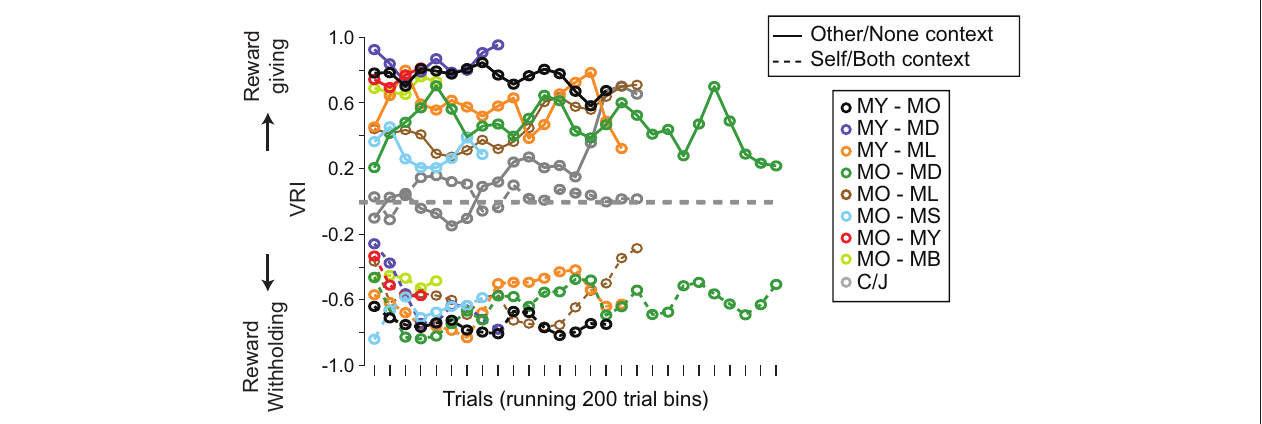
Figure 4 | Temporal progression (moving 200-trial bins with a step size of 100 trials) of context-dependent Vr indices for individual M1–M2 pairs (8 pairs, 64 sessions) and M1–C/J pairs (2 pairs, 13 sessions; see box for pair identities). Data points on the right show individual pair medians and SDs across all trial bins for each